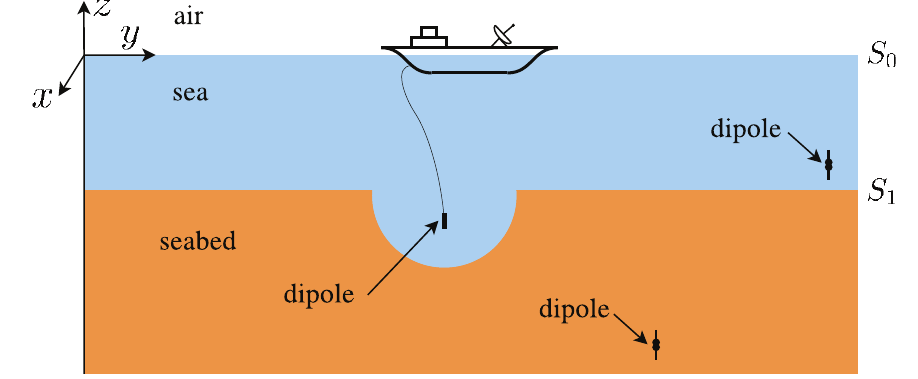
Figure 3. Air–sea–seabed layered media structure with a non-planar surface.